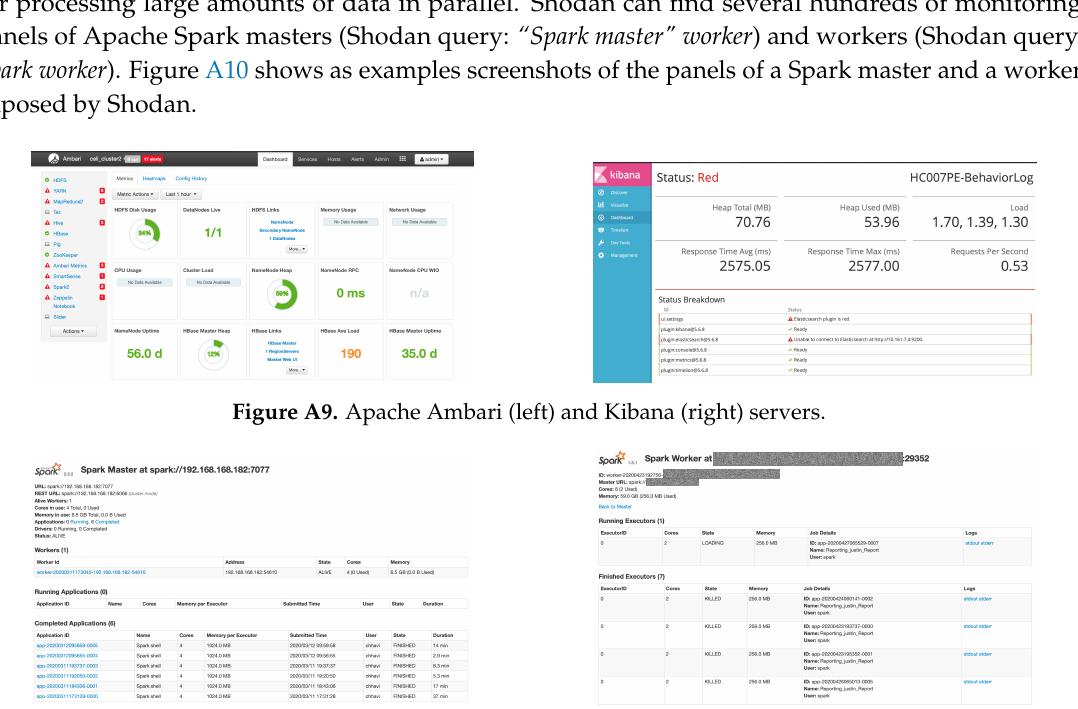
Figure A10. Monitoring panels of an Apache Spark master (left) and a worker